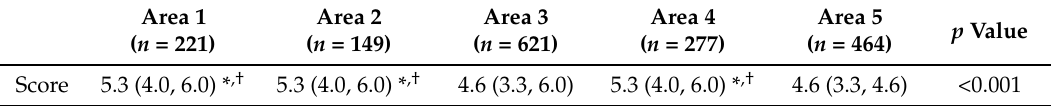
Table 5. MD adherence according to score (out of 10) in the different areas of Spain.